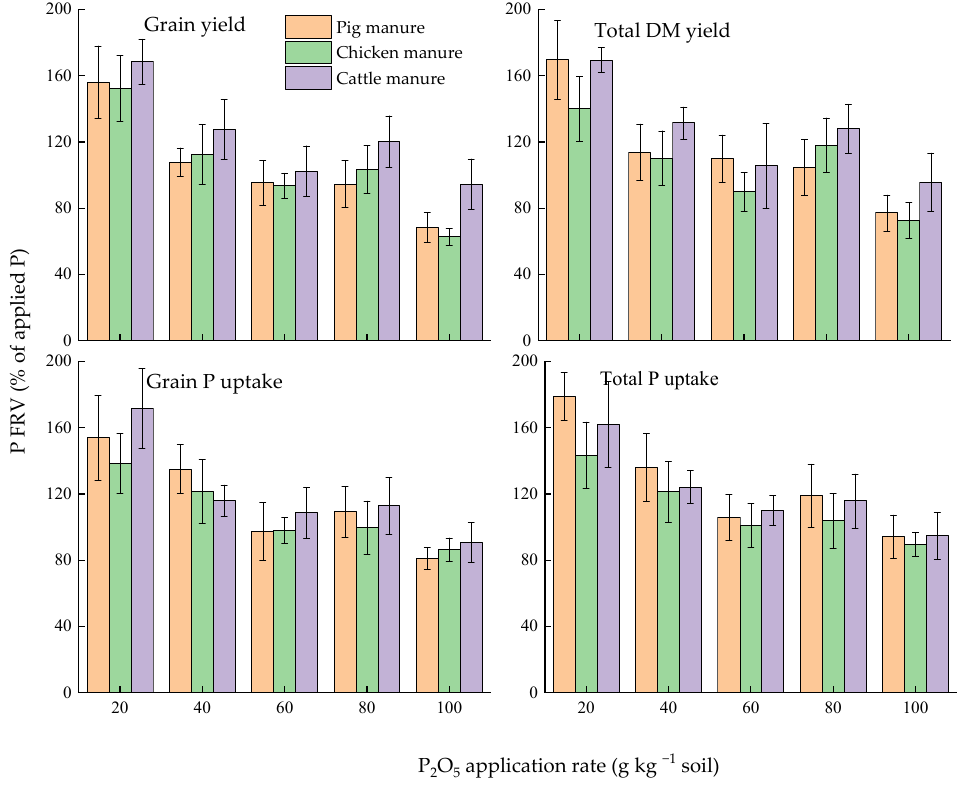
Figure 4. PFRVs of 3 types of livestock manure (% of total applied P) in summer maize. The PFRV was calculated based on the application rate-dependent regression coefficients of grain yield, total dry matter yield (Total DM), grain P uptake, and total P uptake. The error bars indicate standard errors ( n =